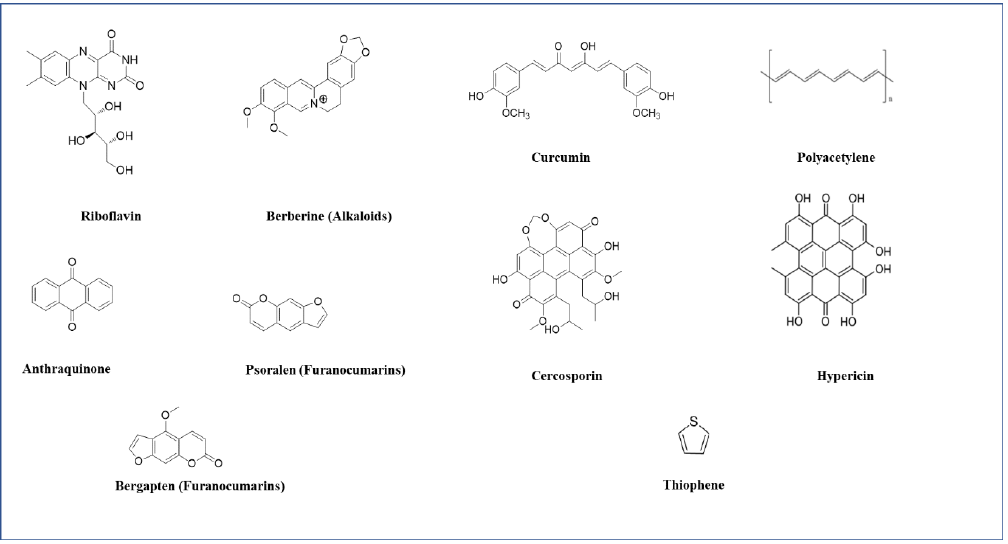
Figure 5. The chemical formulas of the most common photoactive natural PS’s discussed in the